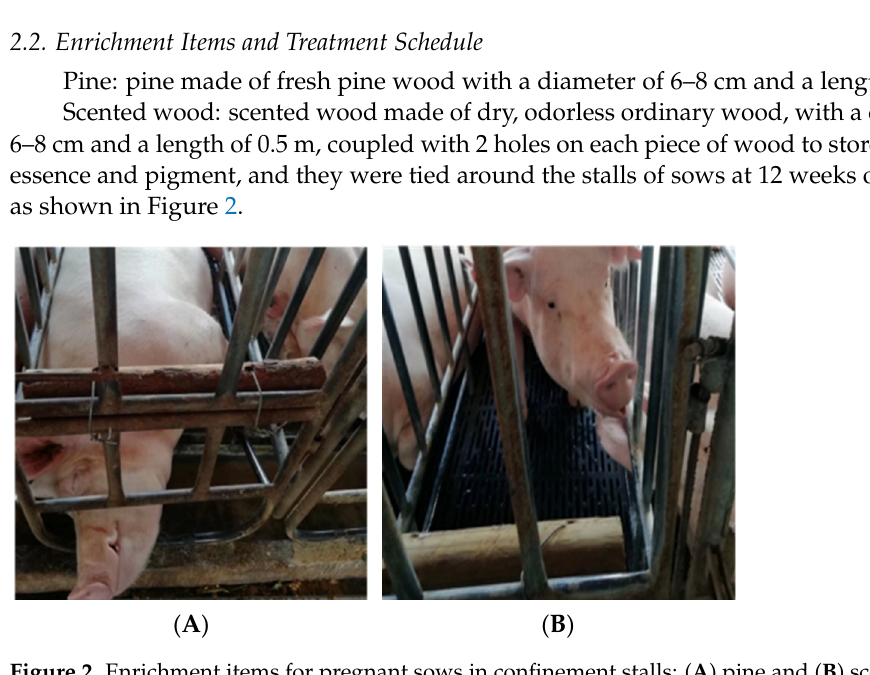
Figure 1. Schematic diagram of confinement stalls.